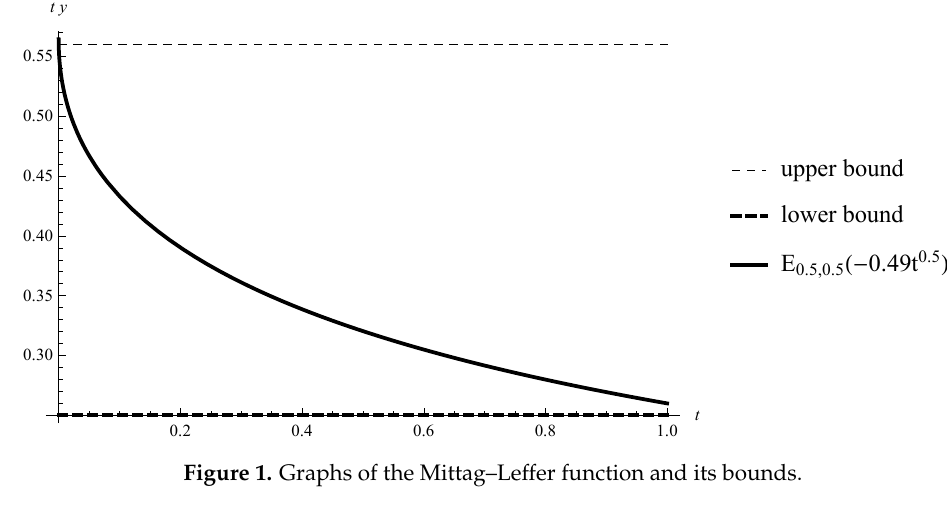
Figure 1. Graphs of the Mittag–Leffer function and its bounds.